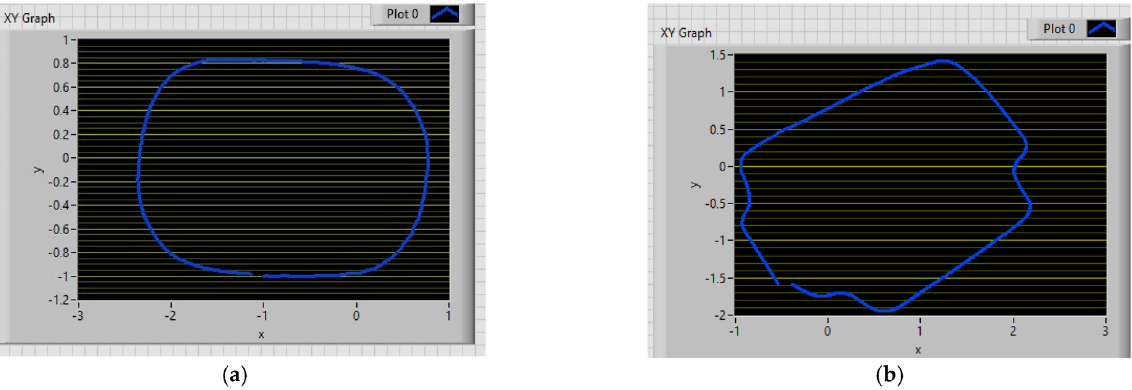
Figure 11. ( a ) Map of the workspace in the Robotino ® SIM program; ( b ) map of the physical test workspace.